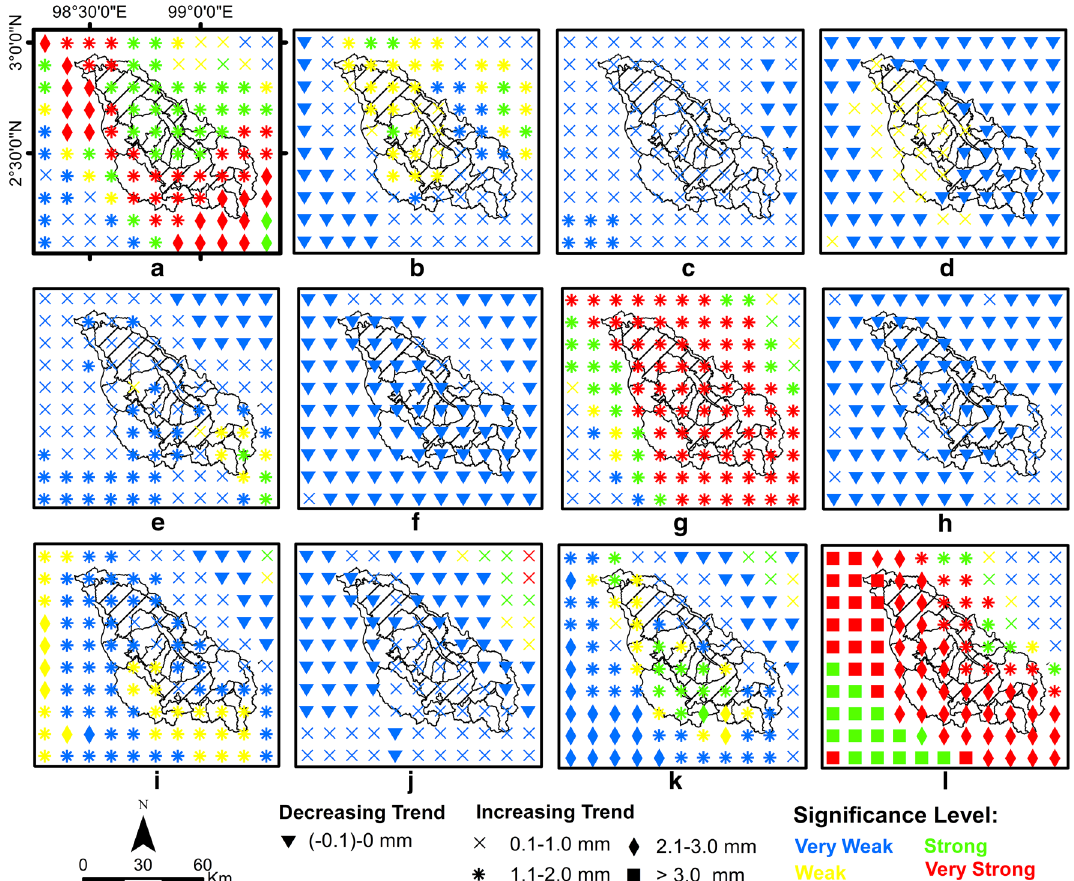
Figure 6. Spatial distribution of rainfall trends in the Lake Toba area for 1981–2020, ( a ) January, ( b ) February, ( c ) March, ( d ) April, ( e ) May, ( f ) June, ( g ) July, ( h ) August, ( i ) September, ( j ) October, ( k ) November and ( l ).